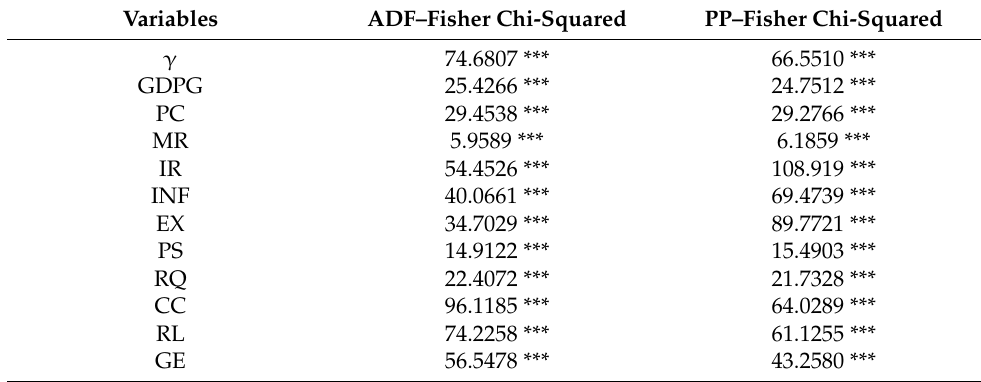
Table 1. Panel unit root test.